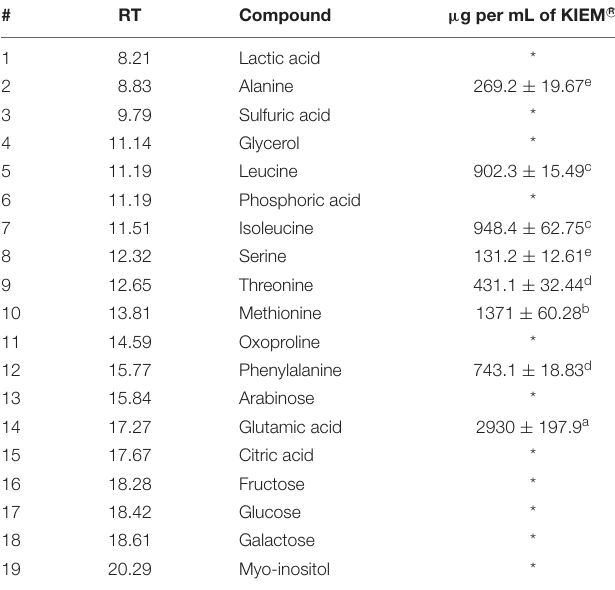
TABLE 3 | GC-MS analysis of the polar metabolites content in the